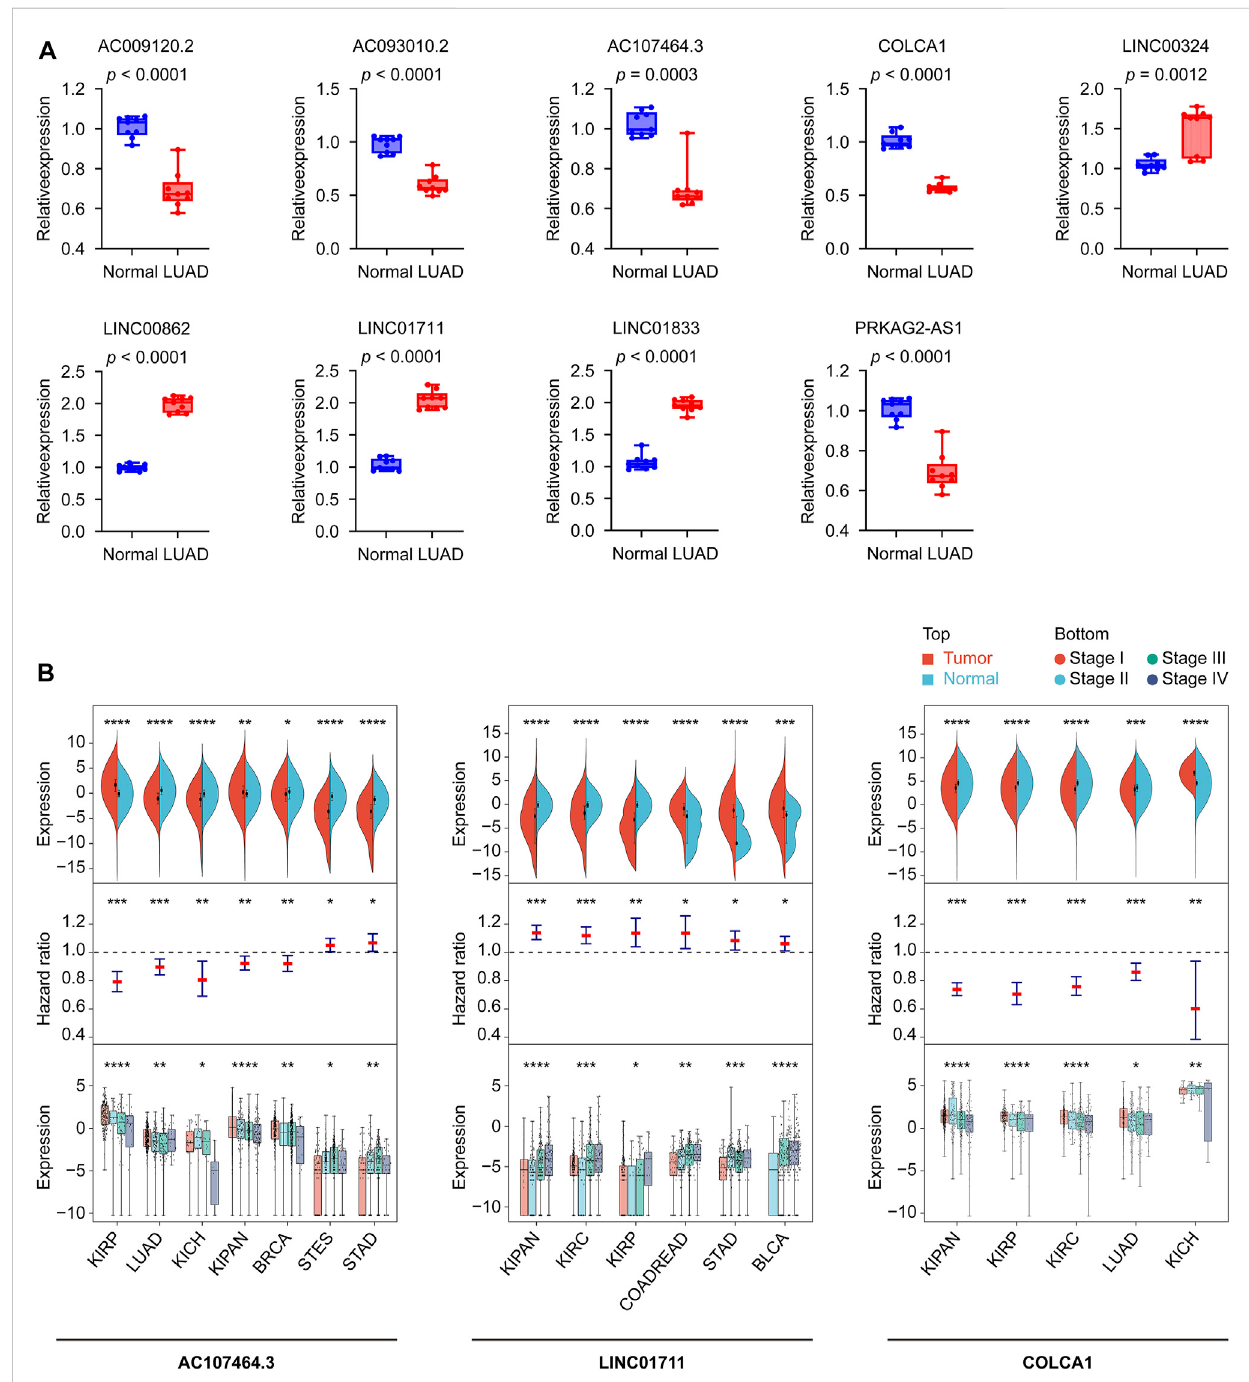
FIGURE 10 Con fi rming the CRLncSig ’ s nine lncRNAs expression patterns in human tissues using real-time PCR and their potential in pan-cancer. (A) The expression levels of the 9 signature lncRNAs in normal lung ( n = 9) and LUAD ( n = 9) tissues detected by real-time PCR. Data were means ± standard deviation. (B) The diagrams show the ability of AC107464.3, LINC01711, and COLCA1 in tumor and normal differential expression, prognosis, and tumor staging. CRLncSig:cuproptosis-regulatedlncRNAsignature;* p- value < 0.05;** p- value < 0.01;*** p-value < 0.001;**** p-value < 0.0001; p-value < 0.05 was considered statistically signi fi cant; BLCA, Bladder Urothelial Carcinoma; BRCA, Breast invasive carcinoma; COADREAD, Colon adenocarcinoma/Rectum adenocarcinoma Esophageal carcinoma; KICH, Kidney Chromophobe; KIPAN, Pan-kidney cohort; KIRC, Kidney renal clear cell carcinoma; KIRP, Kidney renal papillary cell carcinoma; LUAD, Lung adenocarcinoma; STAD, Stomach adenocarcinoma; STES, Stomach and Esophageal